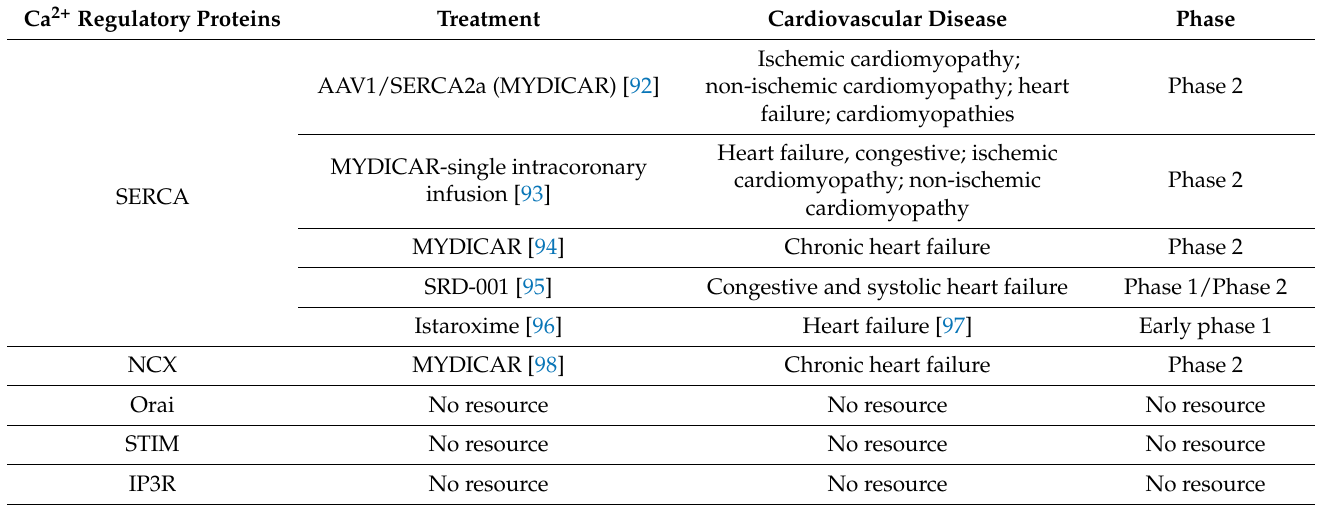
Table 1. Current clinical trials for drugs targeting these Ca 2+ regulatory proteins in the cardiovascular system according to the ClinicalTrials.gov website (available online and accessed on 12 August 2021). Ca 2+ Regulatory